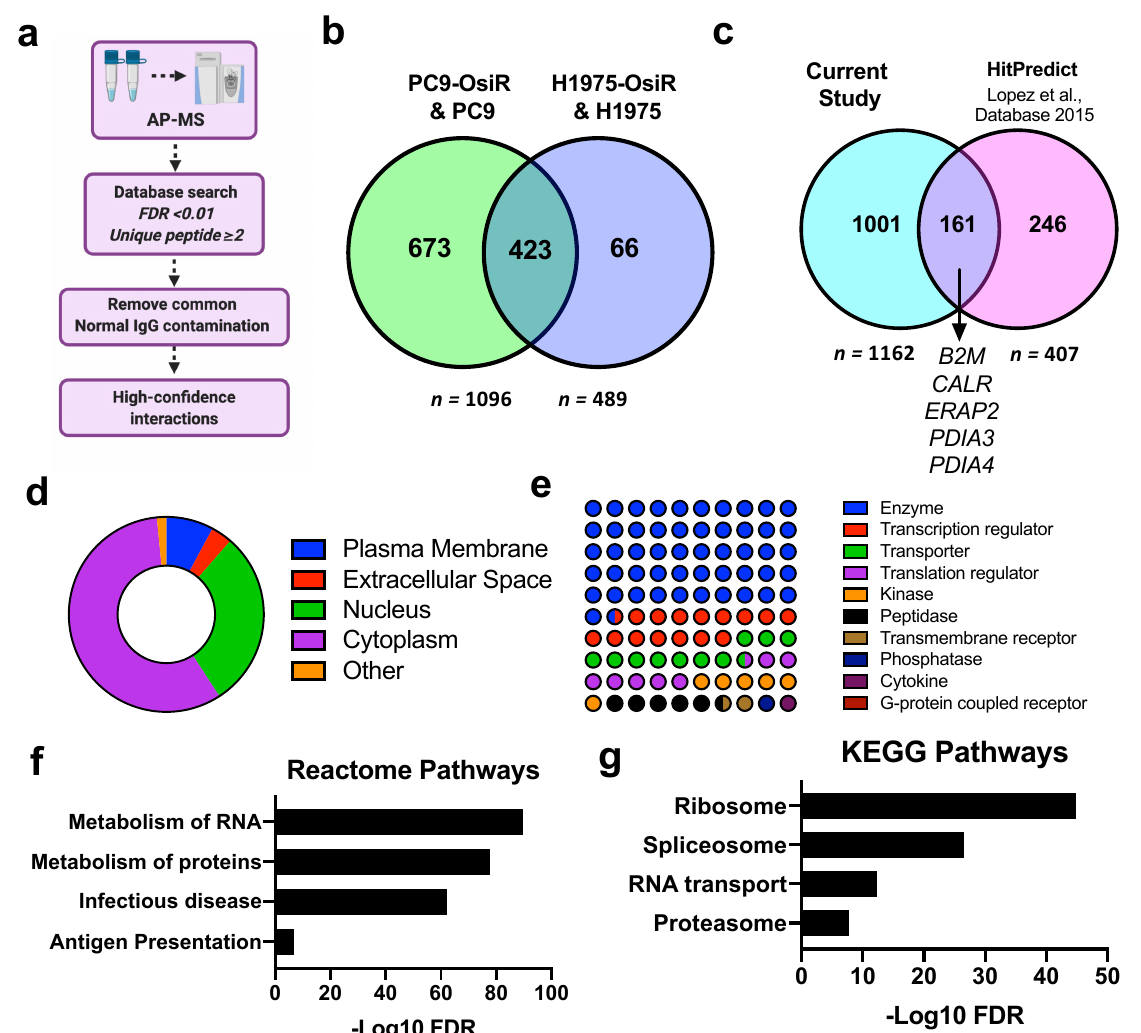
Figure 6. Large-scale affinity purification-mass spectrometry (AP-MS) profiling uncovers direct or indirect interaction partners of HLA class I molecules. ( a ) Schema of the informatic pipeline to retrieve high-confidence interactions (HCIs) of HLA Class I. ( b ) Venn diagram shows the overlapping HCIs between PC9-OsiR/PC9 and H1975-OsiR/H1975 experiments. ( c ) Venn diagram shows the overlapping HCIs of current study and known partners reported in databases. ( d ) The subcellular localization of Class I interacting proteins. ( e ) Dot plot shows the primary molecular functions of class I interacting proteins. ( f , g ) Pathway analysis of identified HCIs using KEGG ( f ) and Reactome database ( g